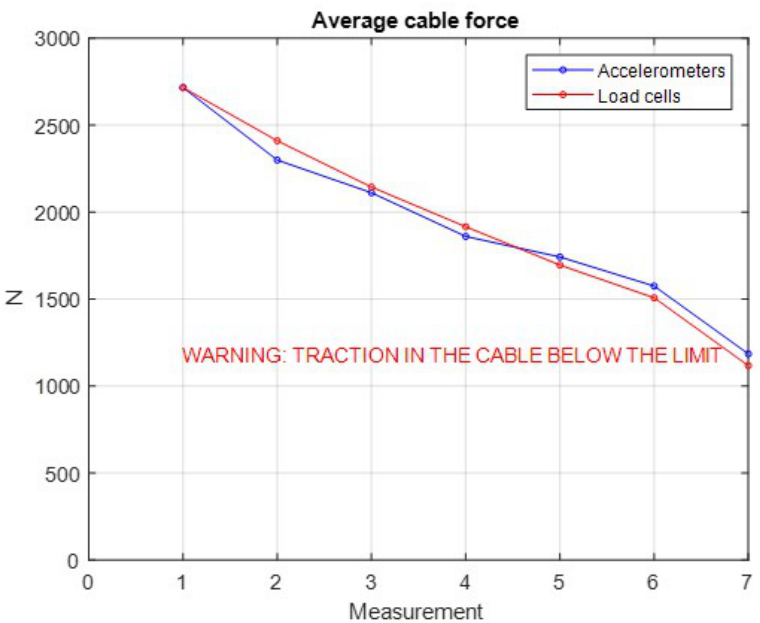
Figure 25. Average cable forces due to manual interventions in the tensioners of Cables 1 and 4.